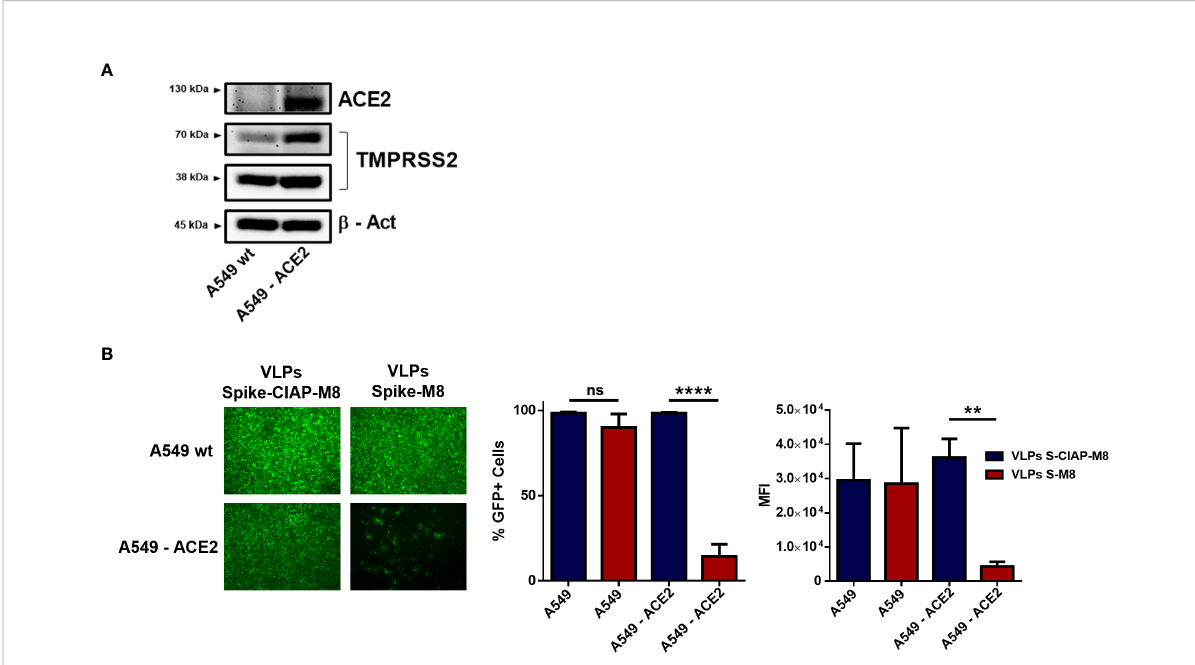
FIGURE 5 Expression of SARS-CoV-2 spike retargets VLPs to ACE2 + cells. (A) Immunoblot analysis representative of ACE2 and TMPRSS2 protein expression in A549 vs A549-ACE2 whole cell extracts, b -Actin was used for normalization. (B) VSV-GFP infection in A549 vs A549-ACE2 cells. Left panel shows fl uorescence microscopy images representative of A549 and A549-ACE2 cells treated with Spike-VLPs-CIAP-M8 or Spike- VLPs-M8 and infected with VSV-GFP (MOI 0.01) for 24h; images were obtained using a Olympus fl uorescence microscope (10x magni fi cation) and analyzed by ImageJ. Histograms show fl ow cytometry analysis indicating the percentage of GFP + cells and the Mean Fluorescence Intensity in A549 and A549-ACE2 cells, treated with Spike-VLPs-CIAP-M8 (blue bars) or Spike-VLPs-M8 (red bars). Data represent mean+SEM from 3 independent experiments. Statistical signi fi cance was de fi ned as follows: **p<0.01 and ****p<0.0001, ns, not signi fi